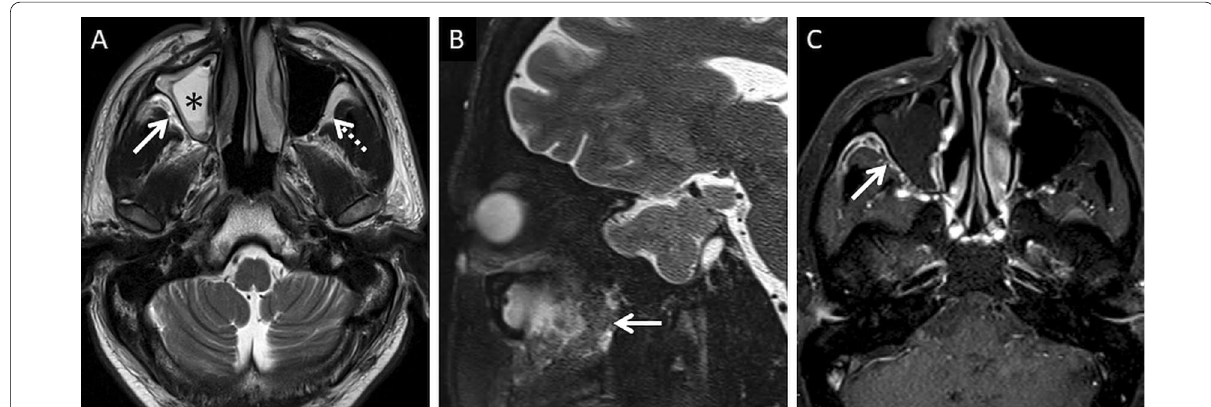
Fig. 8 Retro-antral fat involvement in a patient with histopathologically confirmed MCR. Axial T2W image of the brain ( a ) reveals right maxillary sinus disease (*). Note the slightly heterogeneous appearance of the right retro-antral fat (thick arrow) as compared to the contralateral side (dotted arrow). Sagittal T2-FS image ( b ), obtained for the evaluation of the neck and orbits, confirms stranding of right retro-antral fat (thick arrow). CE FS axial T1W image ( c ) demonstrates intense enhancement of the right retro-antral soft tissue (thick